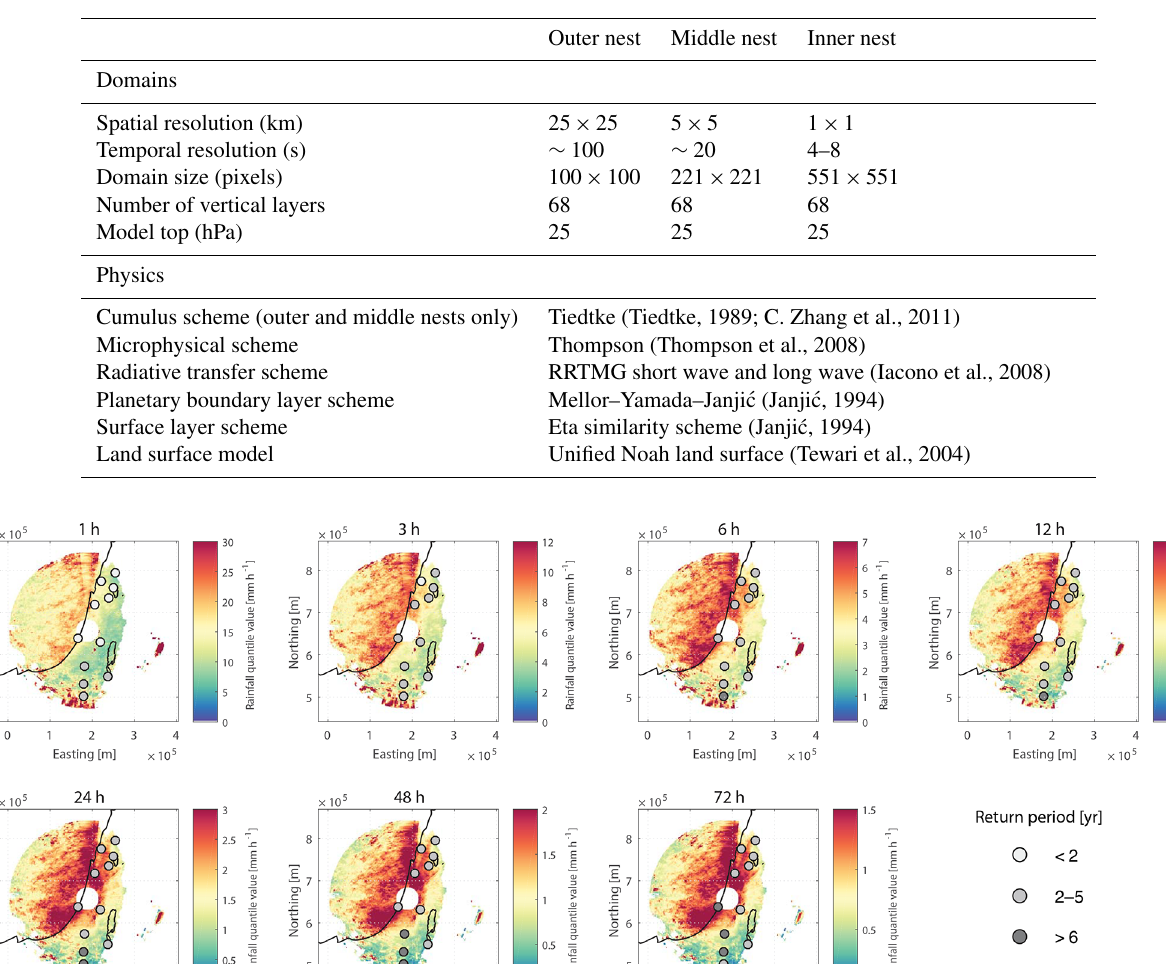
Table 1. WRF model settings and specifications.